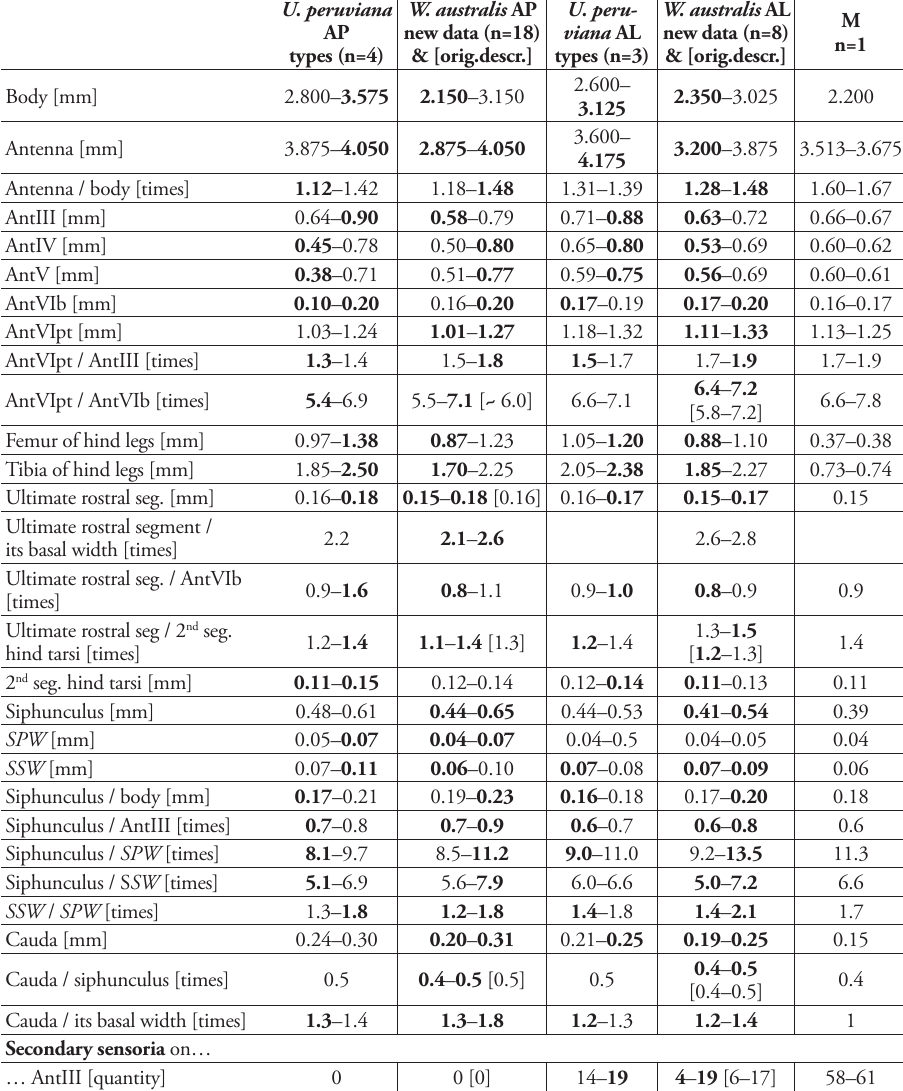
Table 1. Metric and meristic features of viviparous females of Utamphorophora peruviana (Essig), and viviparous females and males of Wahlgreniella australis Delfino (all of them now under the name Delfinoia peruviana ). The measurements are lengths, except where indicated that they are a width or diameter. Values in brackets are data from Delfino’s description of W. australis . Values in bold are new minima or maxima for each character in apterous or alate females based on our data. Abbreviations: AL, alate viviparous females; AP, apterous viviparous females; M, males; n, number of measured specimens; Abd., abdominal segment; AntIII, AntIV, AntV, AntVIb, AntVIpt, antennal segments, b and pt respectively be- ing base and processus terminalis of sixth segment; D , subarticular width of AntIII; seg., segment; SPW and SSW , respectively minimal width of proximal pedunculate portion and maximal width of swollen portion of